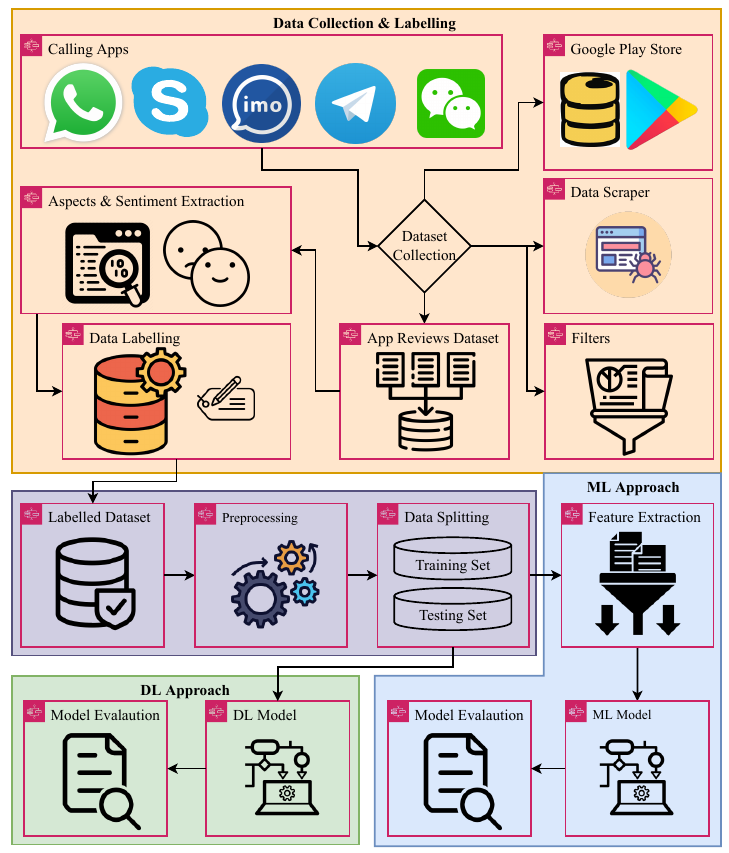
Figure 1. Proposed approach diagram. Table 3. Training and testing set